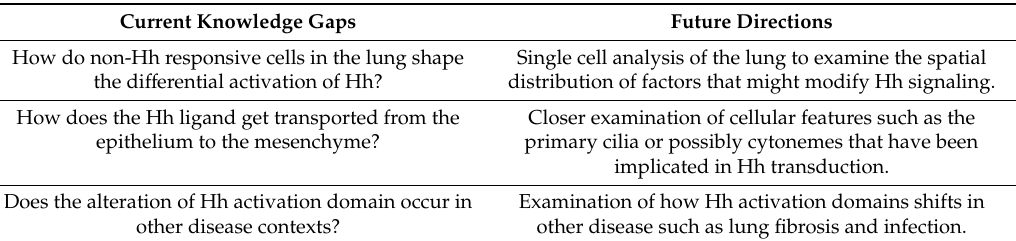
Table 1. Current knowledge gaps and future directions on Hh in adult